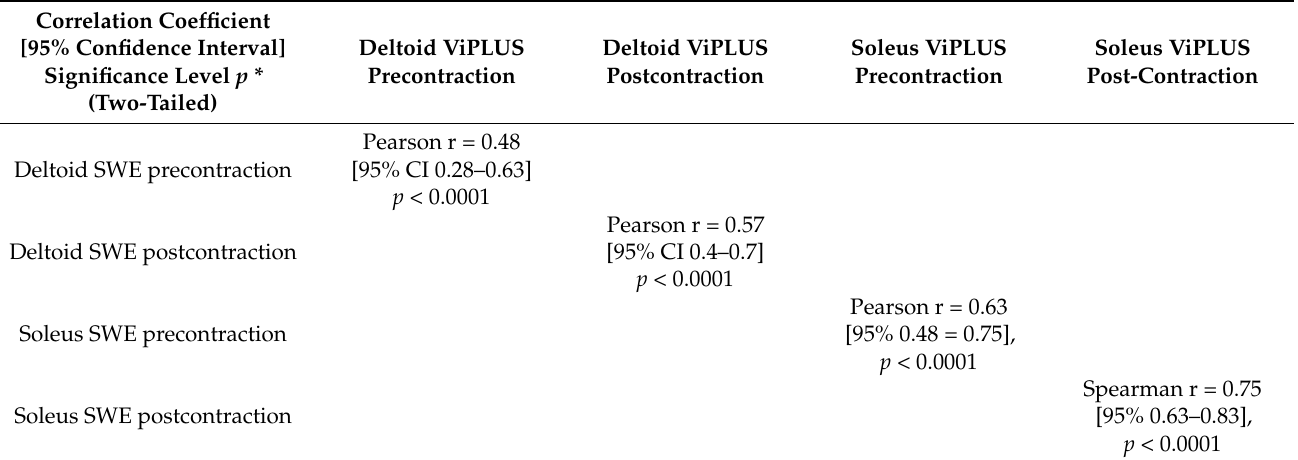
Table 4. Multiple correlations between the elastography and viscosity values.